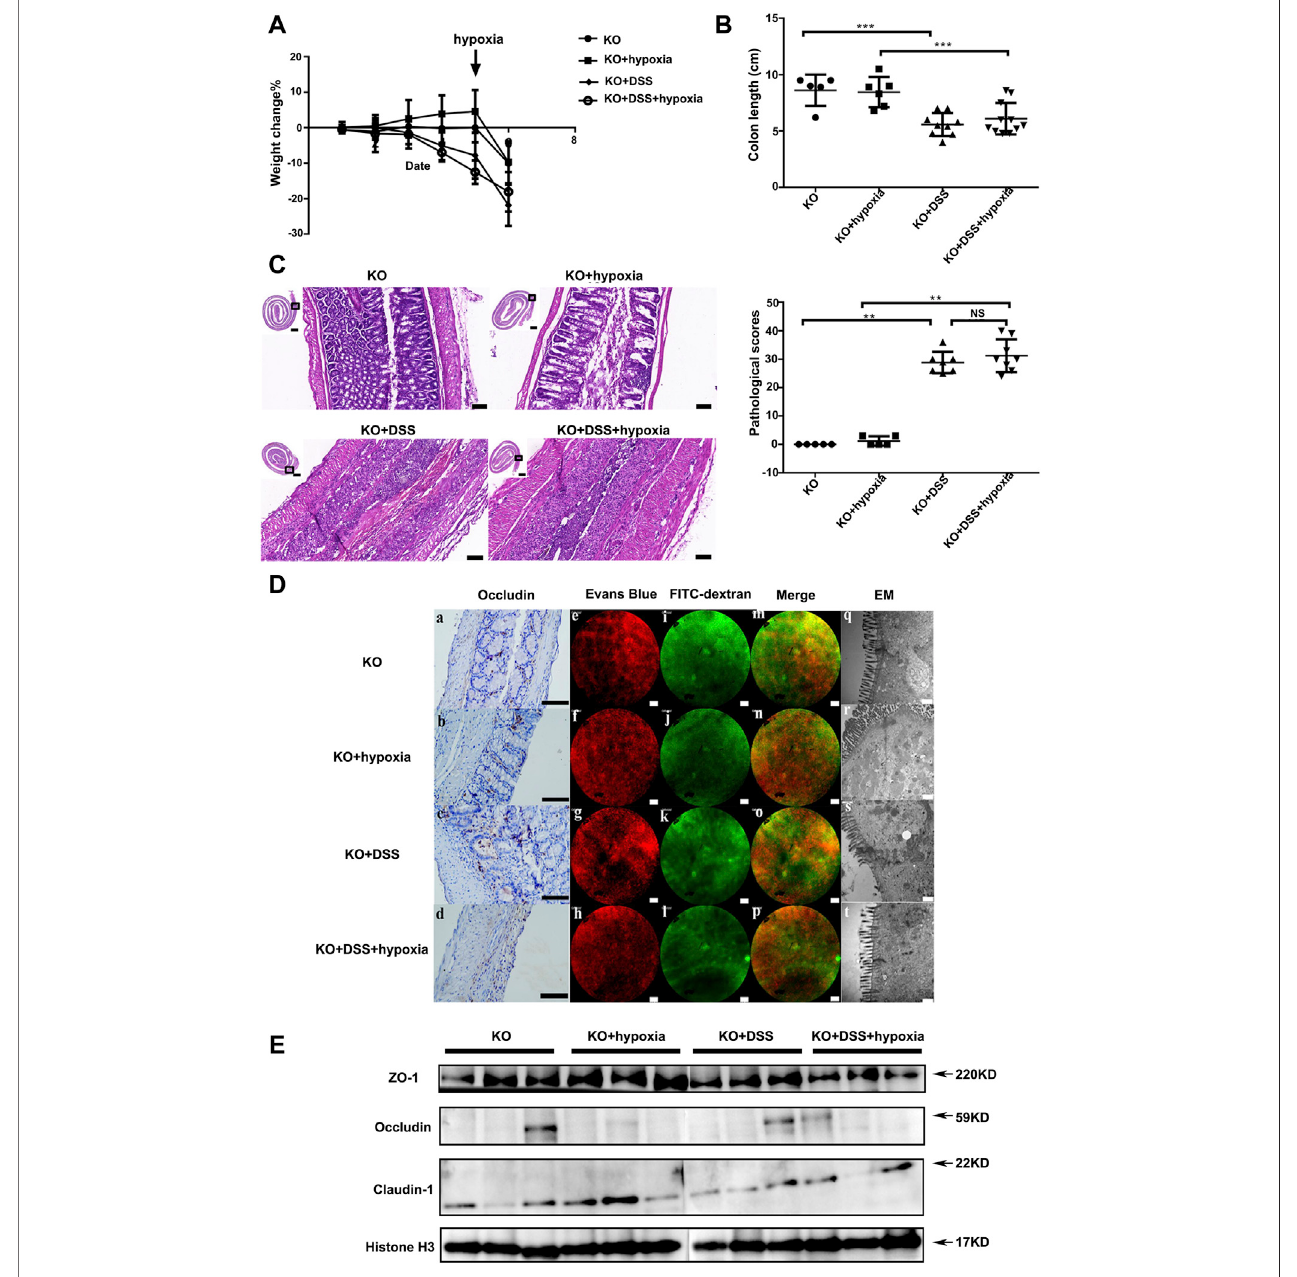
FIGURE3| VDRwasindispensableformucosalbarrierfunctionunderhypoxiainVDRknockoutmic. (A) :ThepercentagechangeofbodyweightinVDRde fi ciency mice:VDRknockoutmice(VDR-KO),hypoxiatreatmentgroup(VDR-KO+hypoxia),DSScolitisinVDR-KOmice(VDR-KO+DSS),andcolitistreatedwithhypoxiagroup (KO+DSS+hypoxia). (B) :Colonlengthattheendoftheexperimentineachgroup. (C) :Pathologicalmanifestationsofthemousecolonandtheirpathologicalscores(n ≥ 5, *** P < 0.001,** P < 0.01; NS:no signi fi cantdifference). Bars =2000 μ m or100 μ m. (D) (a – d):Occludinexpression byIHC in VDR-KO, VDR-KO +hypoxia, VDR- KO + DSS, and KO + DSS+ hypoxia groups. Bars = 100 μ m. (D) (e – p): Regarding intravital fl uorescein penetration experiments in each group, no differences were detected between VDR-KO + DSS group [ (D) g, k, and o) and KO + DSS + hypoxia group [ (D) h, l, and p]. Bars = 50 μ m. (D) (q – t) The tight junction structure under an electron microscope in each group. Bars = 500 nm. (E) . Expression of tight junction proteins (ZO-1,occludin and claudin-1) by Western blotting in each group. The experiment was repeated three times.